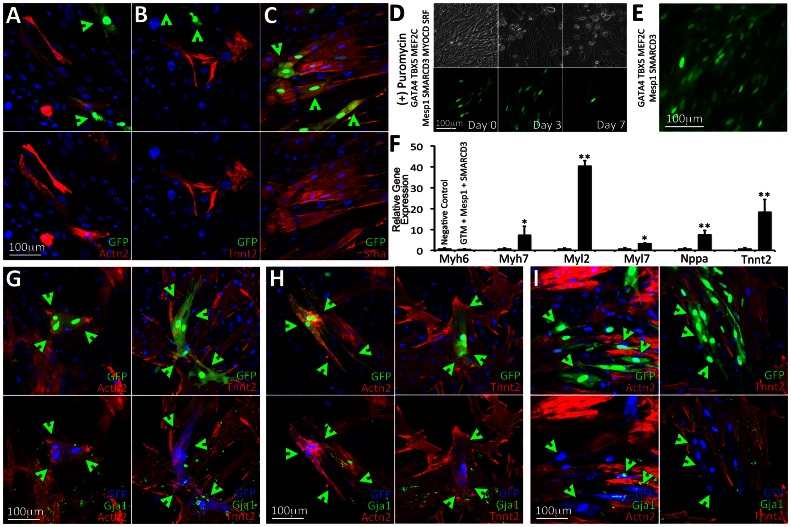
Assaying the level of cardiac protein expression in reprogrammed MEFs and following genetic selection
A–C. GFP(+) cells were readily detected in MEFs transduced with either G4T5MCMDSF, or G4T5MCMDSFM1S3 within 2 days of induction of TF expression. Only rare GFP(+) cells were detected in MEFs transduced with either G4T5MC or G4T5MCM1S3. Using immunofluorescence analysis (day 7) we detected cells staining positive for cardiac antigens Actn2 or Tnnt2 although GFP expression was not always co-localized with these two proteins. We also detected co-localization of GFP expression with Acta2. The GTM label refers to the TF module containing GATA4, TBX5, and MEF2C. D–F. Puromycin was used to positively select for cells activating the transgenic cardiac promoter element in isolated MEFs following transduction and induction of expression of the four TF module combinations. We observed significant death of non-GFP expressing cells following 3 days of low-level puromycin selection (induction day 7+3). In MEFs transduced with either G4T5MCMDSF or G4T5MCMDSFM1S3 GFP(+) cells remained alive but did not proliferate. Following 7 days of puromycin selection, GFP(+) cells for those two TF module combinations peeled off the plastic surface and subsequently underwent apoptosis (D). Rare GFP(+) cells were detected in MEFs transduced with G4T5MCM1S3. The GFP(+) cells proliferated in the presence of puromycin (E). Relative gene expression analysis performed on puromycin-selected surviving GFP(+) cells in MEFs transduced with G4T5MCM1S3 (F). (G–I). Cocultures of transgenic MEFs transduced with the four combinations of TF modules established with freshly isolated neonatal rat ventricular myocytes (NRVMs). Following induction of TF expression for 7 days we assayed cardiac protein expression (Actn2, Tnnt2) and gap junction formation (Gja1). In cocultures where MEFs were transduced with either G4T5MCMDSF or G4T5MCMDSFM1S3 we detected three distinct staining patterns. Firstly, we detected GFP(+) cells with Actn2 or Tnnt2 co-localization. Importantly the cardiac proteins in these cells formed cross-striations (G). Secondly, we detected GFP(+) cells with Actn2 or Tnnt2 co-localization, where however the two cardiac proteins remained unorganized and no cross-striations where detected (H). Thirdly, we detected GFP(+) cells which were negative for either Actn2 or Tnnt2 expression (I). Gja1 staining did not indicate noticeable gap junction formation between the GFP-expressing cells and NRVMs.